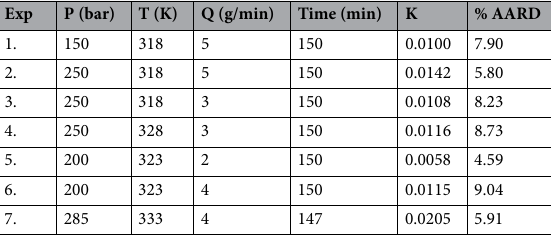
Table 6. Results of